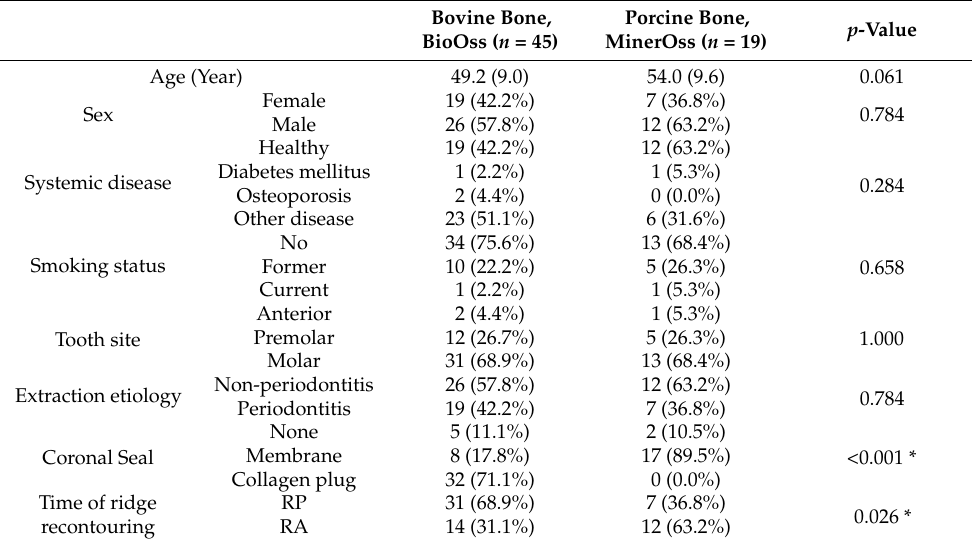
Table 2. Basic characteristics of mandible implant sites for bovine and porcine bone